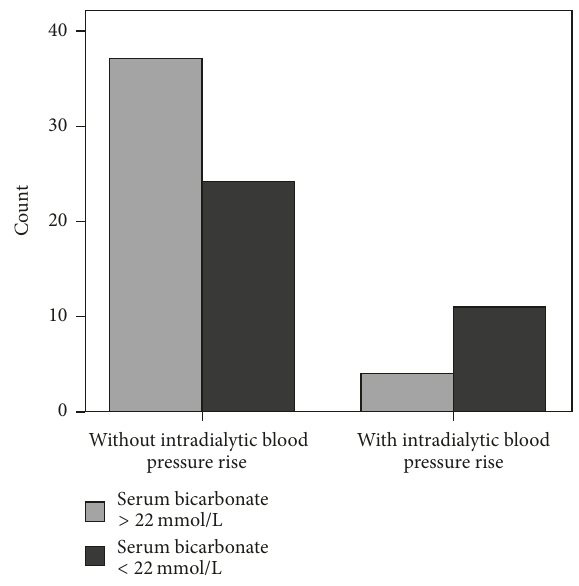
Figure 1: Bar chart for the association between intradialytic hyper- tension and metabolic acidosis state defined by serum bicarbonate less than 22 mmol/L ( 𝑥 2 = 5.6 , 𝑝 = 0.01 ).